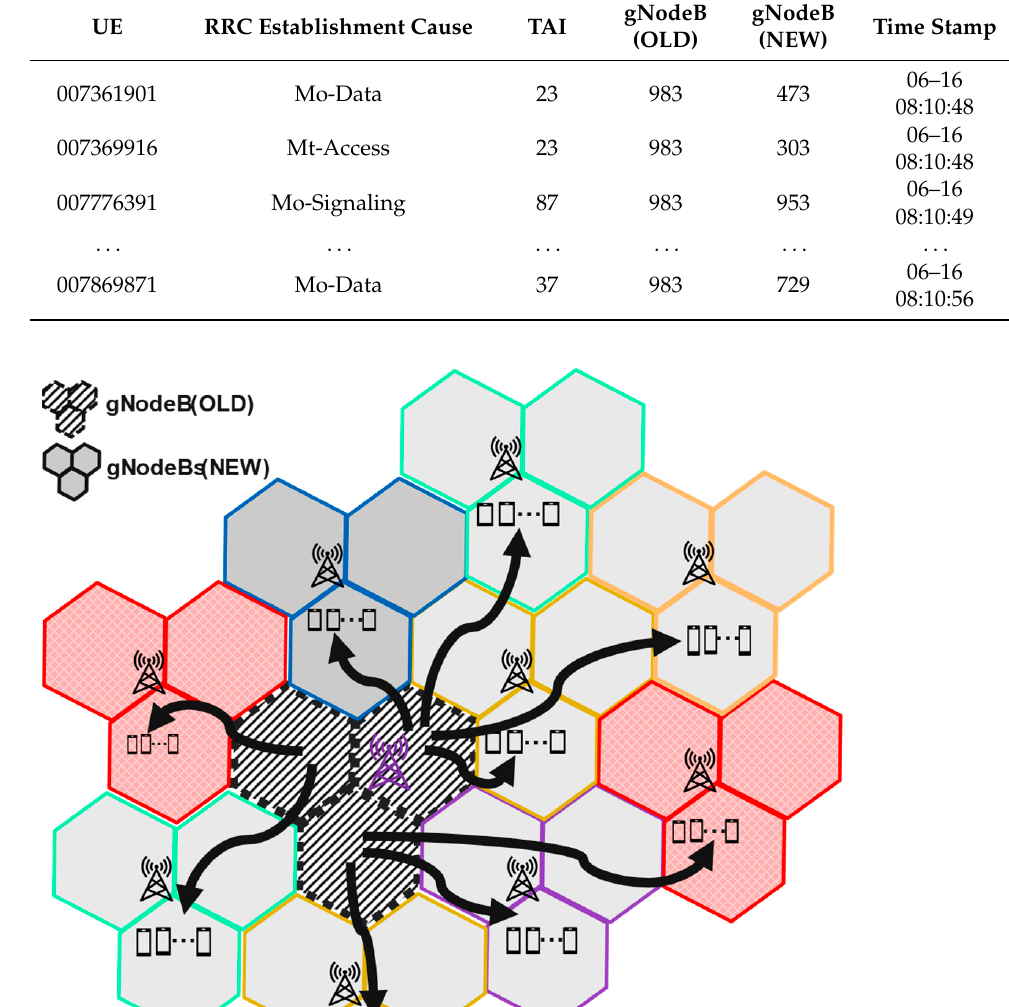
Figure 9. Experiment environment for proposed paging. as UE group 2. The settings for all the gNodeBs and UE were organized in the order of time in the 5G simulator, whereas the gNodeB list and transition probability based on the